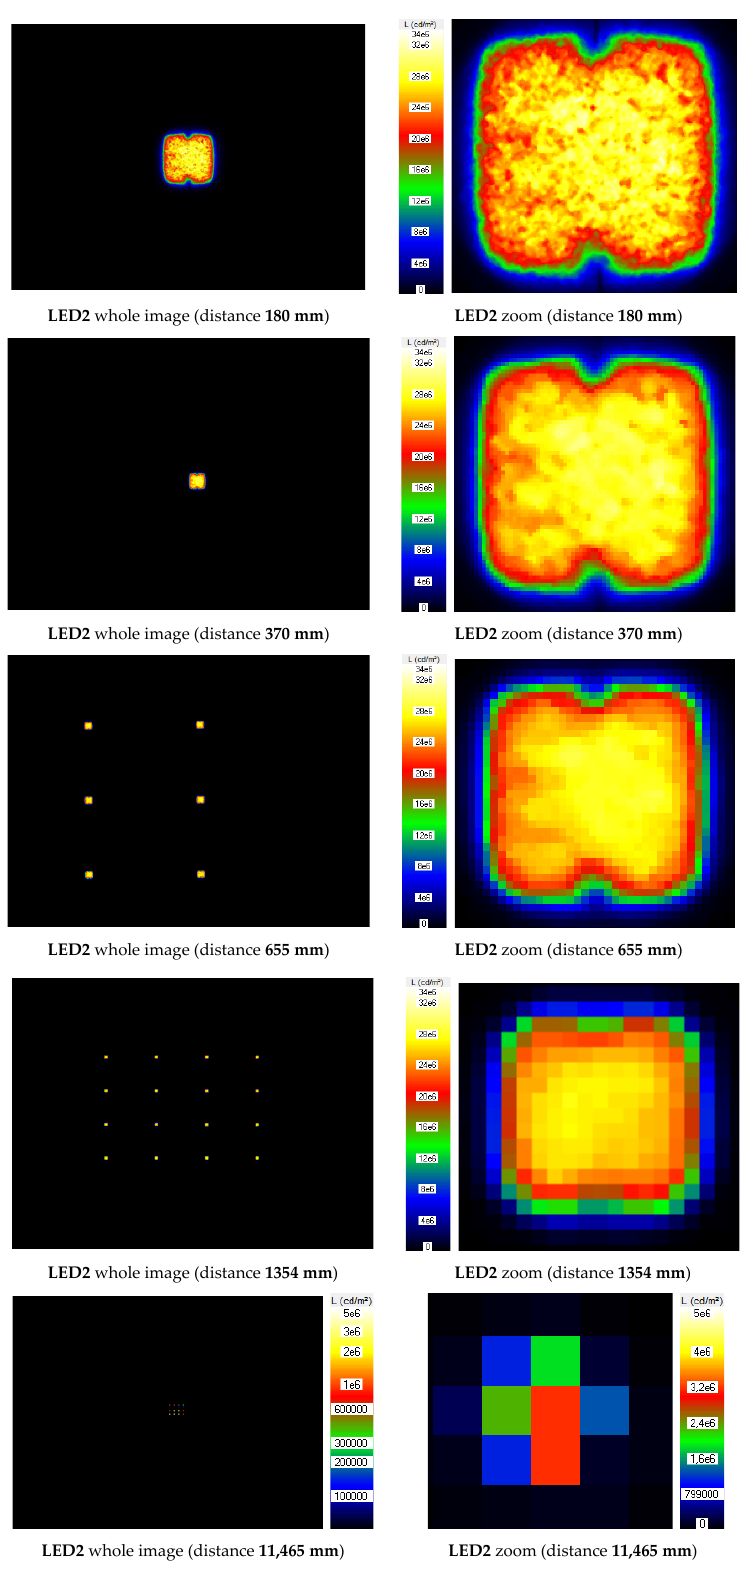
Figure 7. The view of the luminance distribution on the surface of LED 2 for different measurement distances (the left picture shows the view of the actual LED image on the ILMD, and the right picture shows a magnification of the image of the tested LED2).